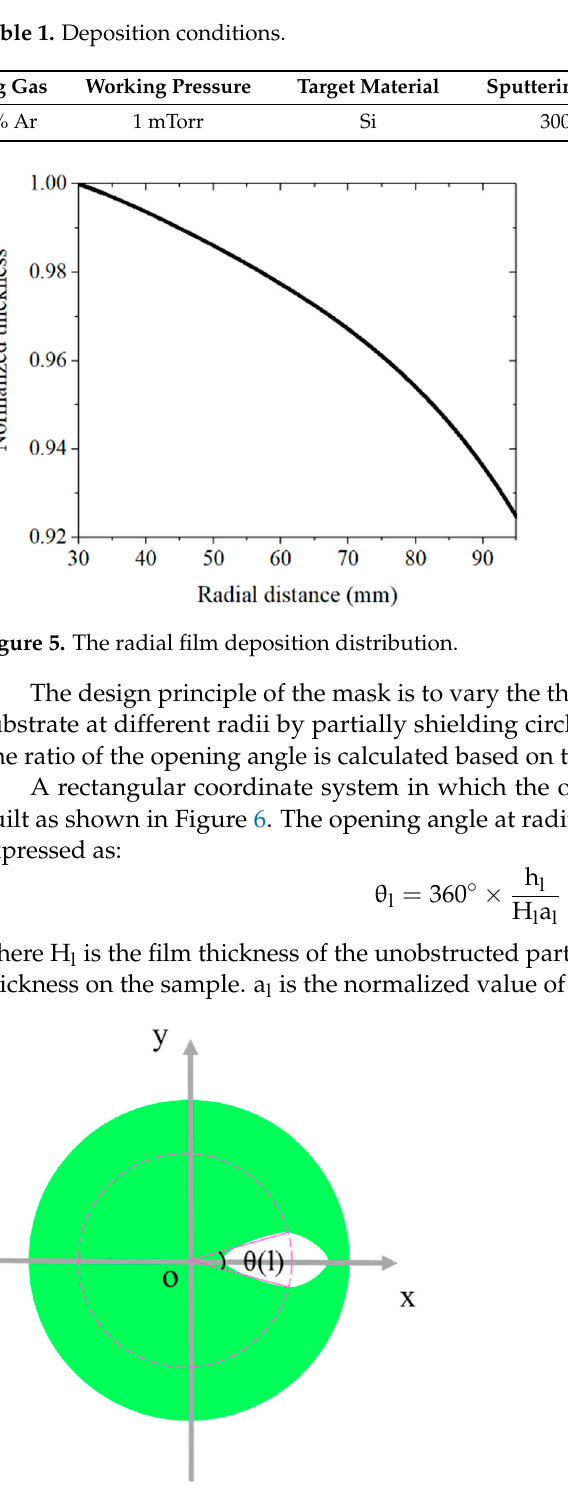
Figure 6. Schematic diagram of the calculation of the mask design opening ratio.